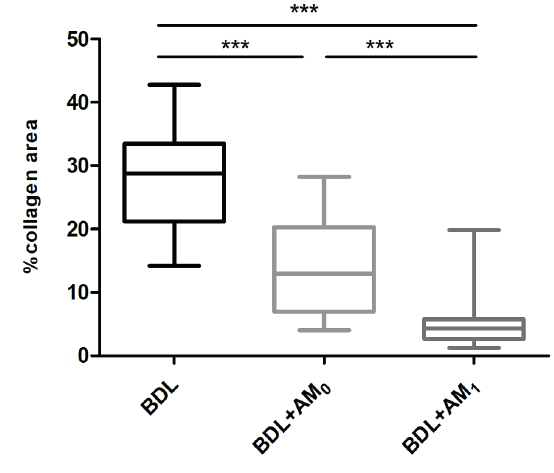
Figure 4 - Quantitative evaluation of collagen deposition. median and interquartile range of collagen deposition in the experimental groups, after 6 weeks of BDL. *** p